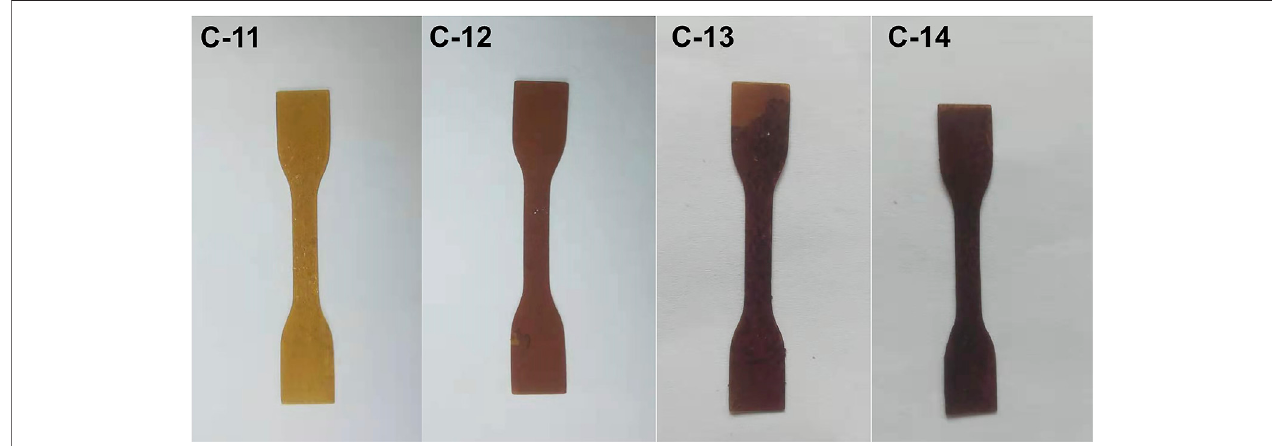
FIGURE 5 | Images of covalent bond crosslinked elastomers by altering the dosage of TA.